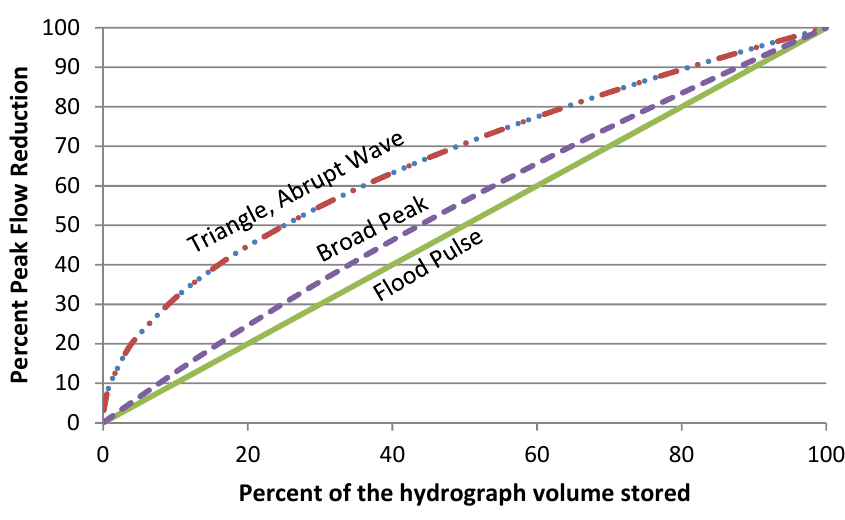
Figure 3. Effect of hydrograph shape on the Minimize Flood Peak (MFP)